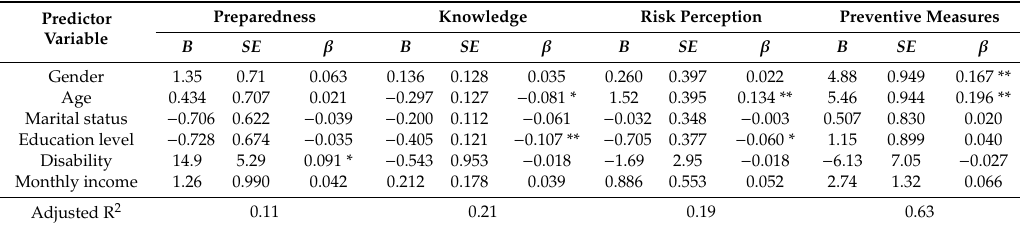
Table 2. Results of a multivariate regression analysis concerning subscales (preparedness, knowledge, risk perception, preventive measures) for coronavirus disease (n =